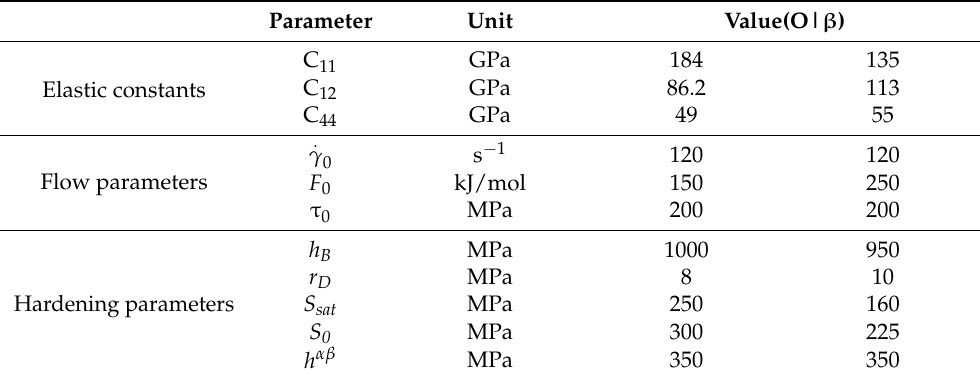
Figure 6. ( a ) RVE with O phase (red) and β phase (blue); and ( b ) periodic boundary conditions.